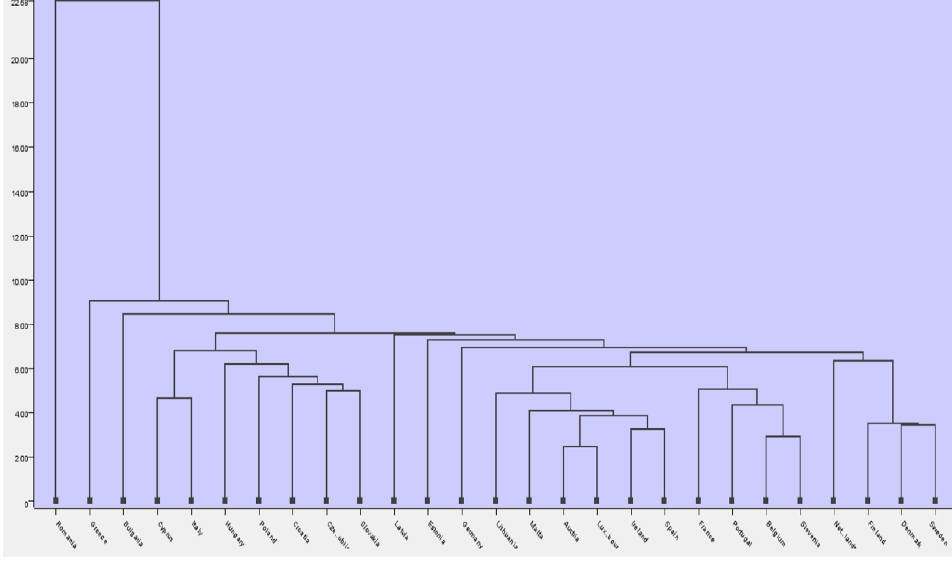
Figure 9. Dendrogram of clusters. Source: authors’ compilation in KNIME analytics platform.